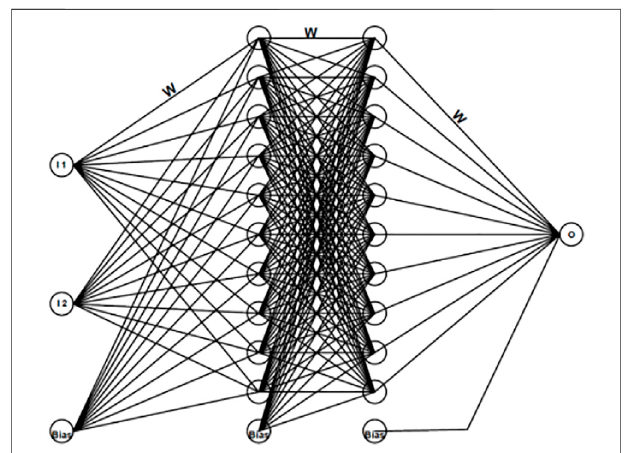
FIGURE 10 | ANN structure.